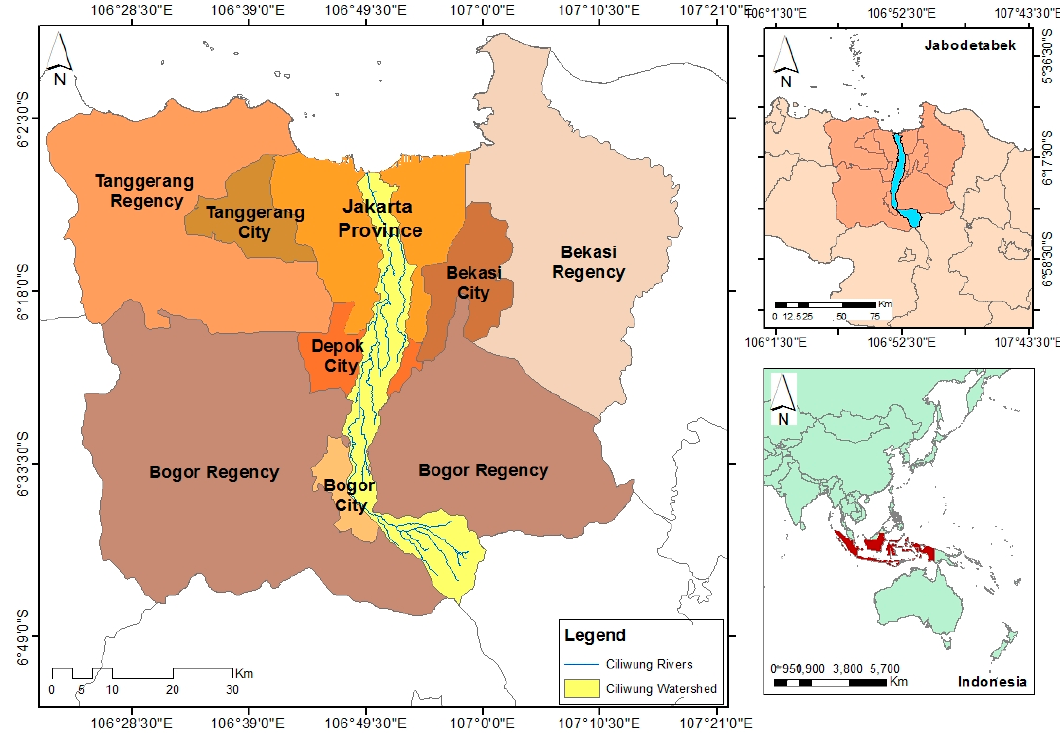
Figure 1. Location of the Ciliwung River basin.